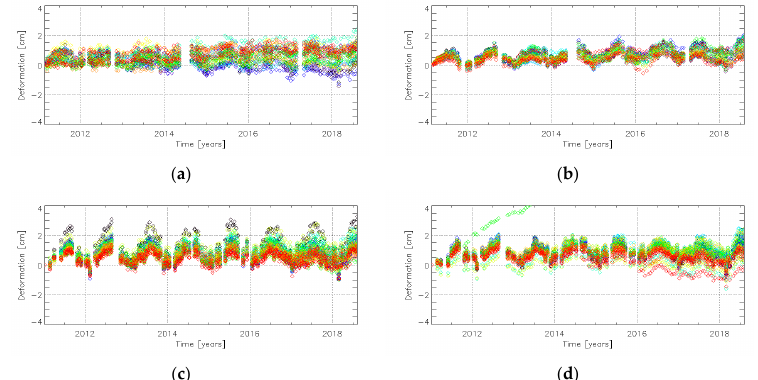
Figure 8. Plots of the estimated deformation time series for the coherent pixels in the area of interest related to the collapsed pillar provided in Figure 7 for ( a ) SBAS and ( b ) TomoSAR results relevant to the ascending dataset, and ( c ) SBAS and ( d ) TomoSAR results for the descending dataset. A similar analysis was performed on the southern roadway of the bridge deck. Similar to the northern roadway case, the coherent pixels located at the bridge deck on the southern roadway were isolated. The results are provided in Figure 9, in which the analysis was limited to the points located within the red rectangle and characterized by an estimated height greater than 40 m above the sea level. The plots of the estimated height for the selected pixels, represented as red diamond, and for the ground ones (black diamonds) are reported in Figure 10. Again, the very high CSK resolution allows easily recognizing the first tower and, particularly on the descending dataset, the stay from the top of the tower to the bridge deck, as well as pillars of second and third towers. These plots also highlight the significant different coverage between the ascending and descending datasets on the southern flank of the bridge: because of the significant shadow effect on the descending dataset, the density is drastically reduced on the bridge deck whereas even almost no coherent pixel is detected on the ground segment underling the southern roadway of the bridge. As for the northern roadway, the plots of the estimated deformation mean velocity within the red rectangle, provided in Figure 11, do not show any significant deformation of interest neither on the pillars, nor at the deck level and specifically in correspondence with the connections of the stay-cables. It is worth noting that, despite the choice of the reference pixels far away from the area of interest, the coverage over the bridge is fairly dense. The stable behavior is also confirmed by the close-up analysis in Figure 12, where the pixels located in correspondence to the tower of interest were isolated. For each of these points, the estimated time series depicted in Figure 13 confirm the prevailing seasonal behavior. In order to further provide information about a possible precursor, our displacement study also includes the analysis of the detected PS located at the ground level in correspondence with the collapsed tower. These results, provided in Figures S1 and S2 in the Supplementary Materials, further confirm that no significant displacements were detected. As a final point, it is once again worth remarking that the results achieved by exploiting the two independent SBAS and TomoSAR approaches are in very good agreement, regardless of the reference pixels selection, thus confirming the robustness of the applied MT-InSAR processing approaches.